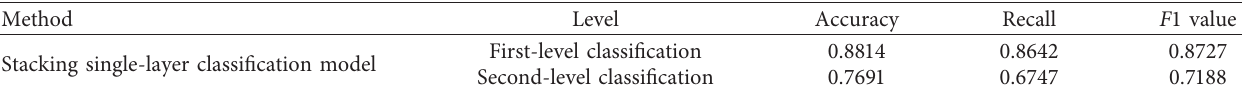
Figure 7: Evaluation indexes of the deep learning integration model under different weights. (a) First-level classification. (b) Second-level classification. Table 4: Single-level text classification results of the stacking model.